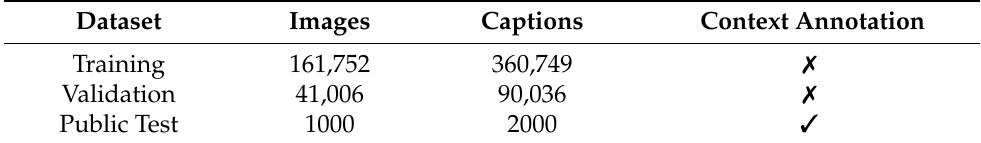
Figure 1. Distribution in categories and content of COSMOS dataset. Table 1. COSMOS Dataset